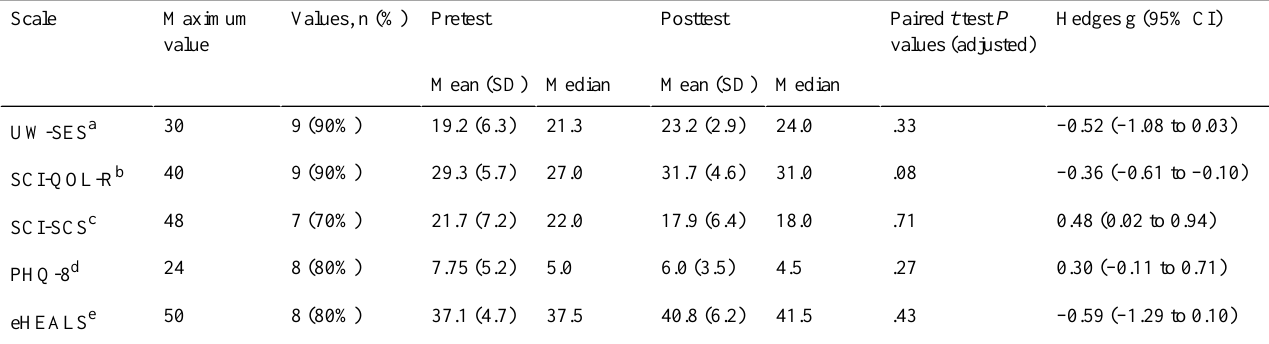
Table 3. Pretest and posttest measures.